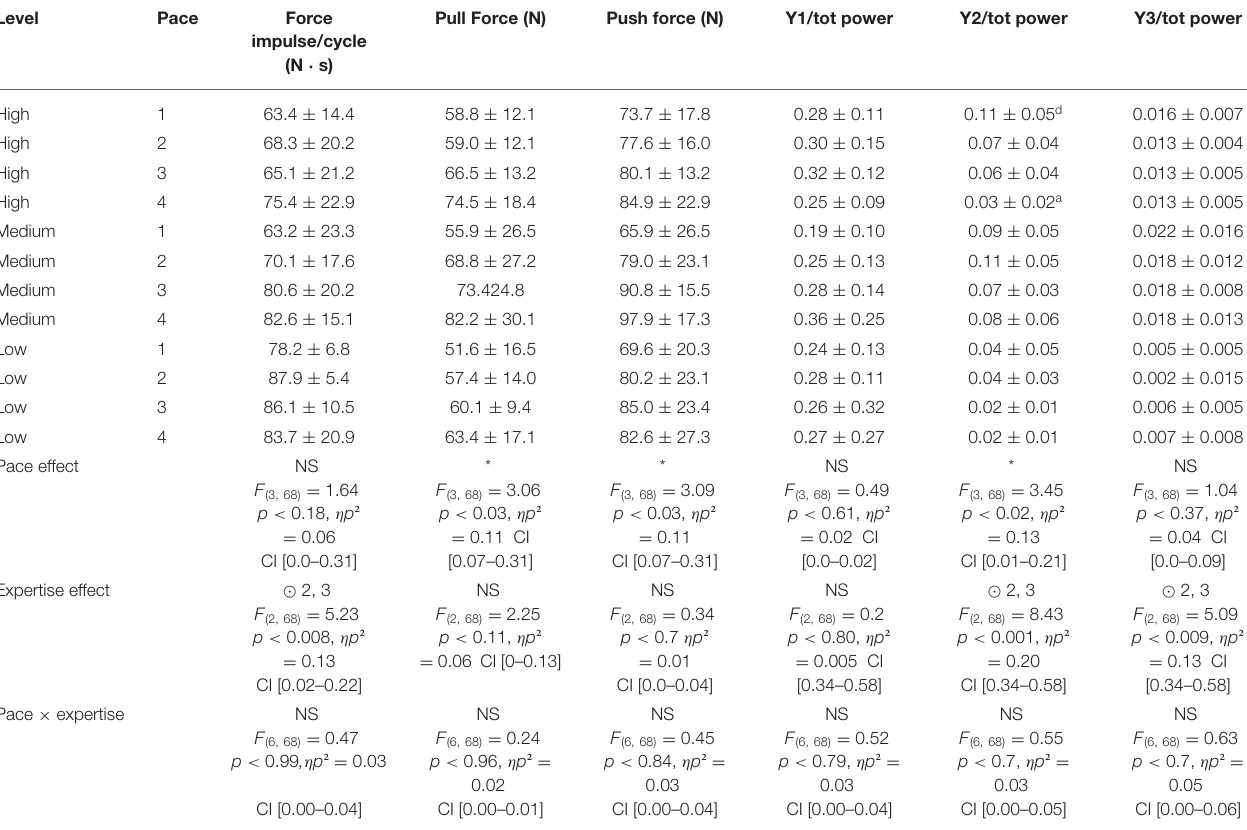
TABLE 5 | Kinetic parameters according to pace and expertise